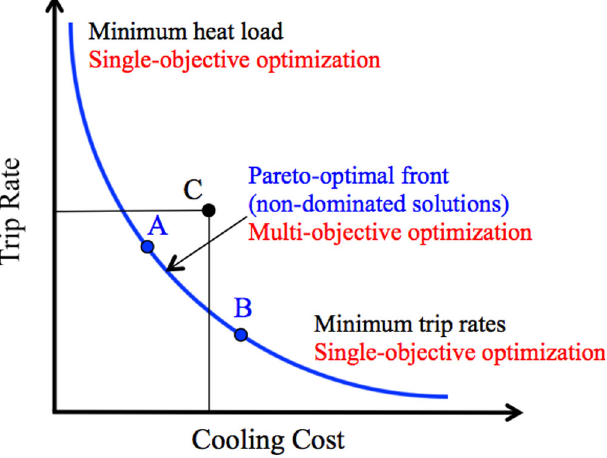
W.FIG. 2. The Pareto-optimal front for the simultaneous optimi- zation of the linac ’ s cooling cost and trip rate (multiobjective optimization). Asymptotically, the solutions at the extremes of the Pareto-optimal curve represent the single-objective minimi- zation of the cooling cost (top left portion of the curve) and the single-objective minimization of the trip rates (bottom right portion of the curve). Solutions A and B are on the Pareto- optimal front, while solution C is not because it is dominated by solution A (A is within the rectangle defined by C ’ s